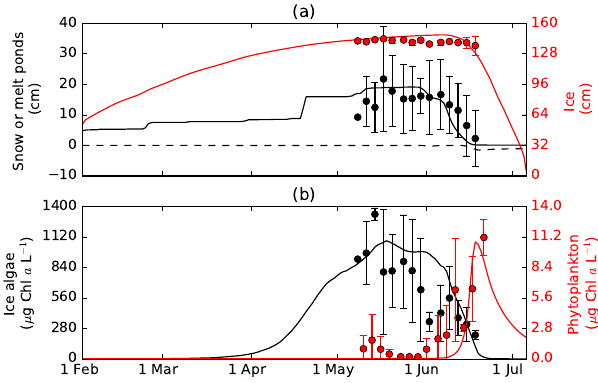
Figure 2. Simulated (lines) and observed (dots and bars) time series of (a) snow (black solid) and melt-pond (black dashed) depths (cm) and ice thickness (cm) (red) and (b) ice algal biomass (µgChl a L − 1 ) in the bottom 3cm ice (black) and phytoplankton biomass (µgChl a L − 1 ) averaged over the upper 10m water col- umn (red) in Resolute Passage during 2010. In panel (a) , the neg- ative values present the depth of melt ponds. Also in panel (a) , the observed values show the average (dots) and 1 standard deviation (vertical bars) of samples collected at three sites of high (>20cm), medium (10–20cm), and low (<10cm) snow cover. In panel (b) , the observed ice algal biomass shows the average (black dots) and 1 standard deviation (vertical bars) of samples collected in ice cores under high, medium, and low snow cover sites, while the observed phytoplankton biomass shows the average (red dots) with ± 1 stan- dard deviation (vertical bars) of samples collected in seawater at 1.5, 2, 5, and 10m depth. Note that the biomass for both ice algae and phytoplankton is expressed in terms of volumetric concentration. Hence, despite high concentrations in the sea ice, they are confined to a very small vertical range (3cm) compared to those concentra- tions in the upper 10m of the water